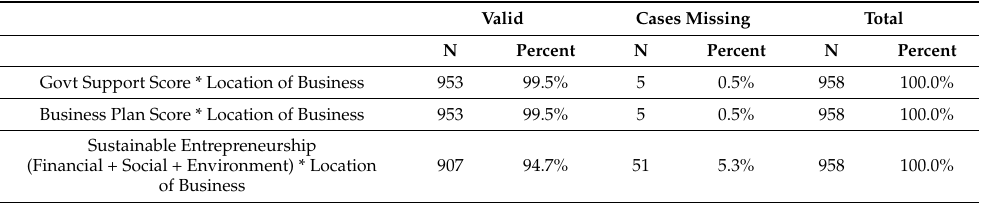
Table 2. Crosstabs (case processing summary).